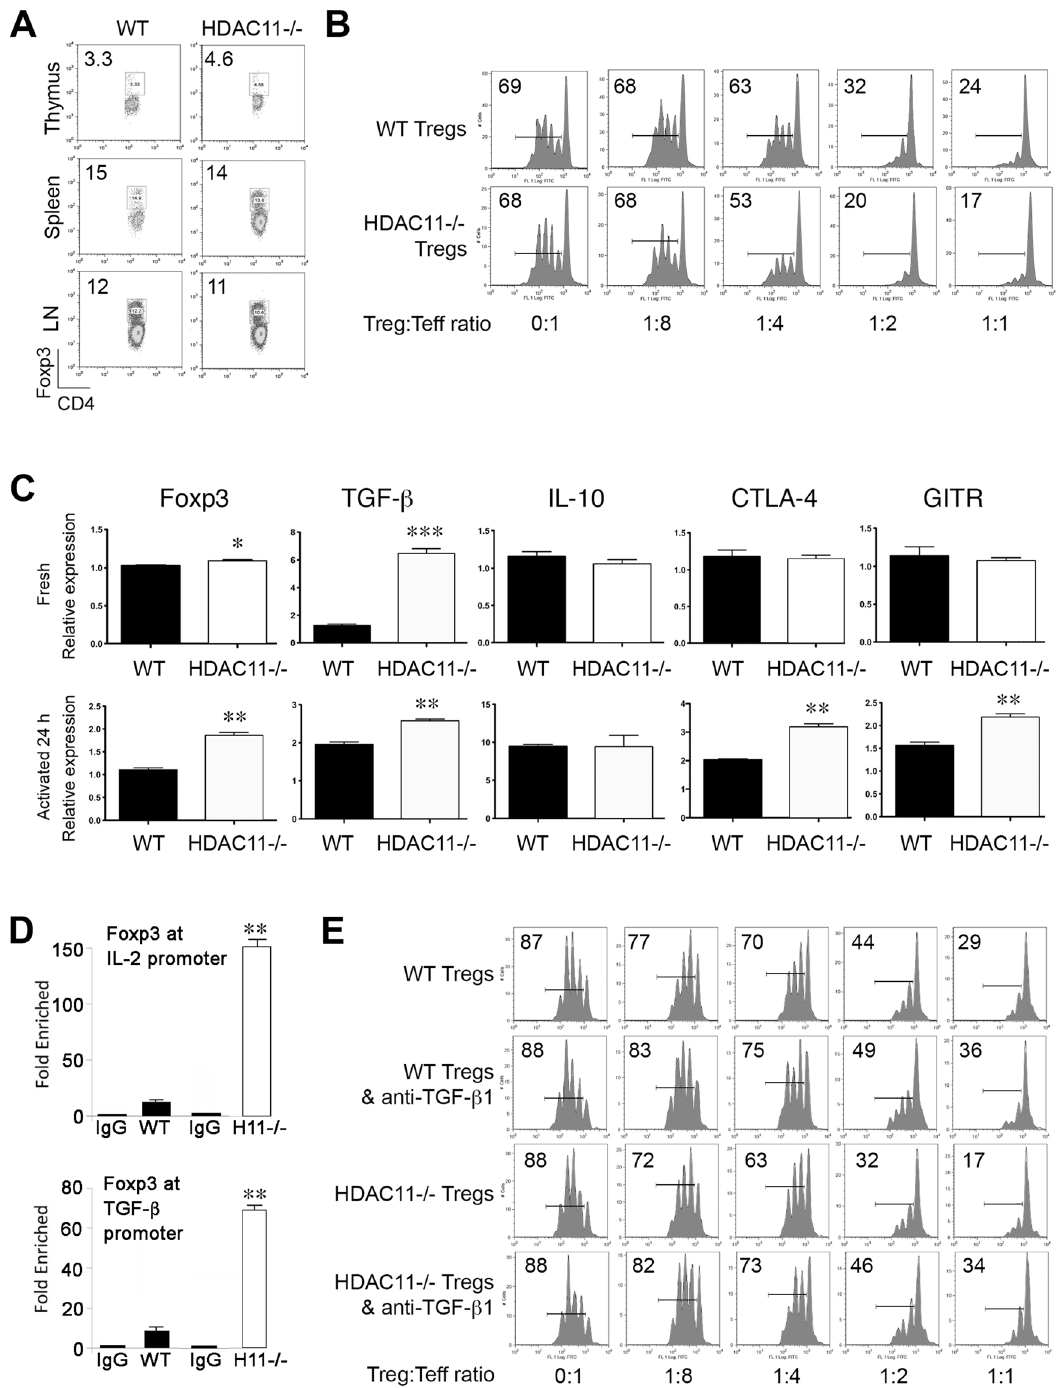
Figure 2. Conditional HDAC11 deletion promotes Foxp3 + Treg suppressive function. ( A ) Deletion of HDAC11 within developing Foxp3 + Tregs did not affect the proportions of thymic, splenic or LN Treg cells; data are from 4 to 6 weeks old male mice, and are representative of results in 4 mice/group. ( B ) In vitro Treg suppression assay of the proliferation of CFSE-labeled WT Teff cells using Tregs from WT vs. conditional HDAC11 − / − mice, with percentage of proliferating cells shown in each panel, and representative of 4 separate experiments. ( C ) Gene expression (qPCR) by WT vs. conditional HDAC11 − / − Tregs at rest or activated with plate-bound CD3/CD28 mAbs for 24 h; normalized gene expression data are shown as mean ± SD, 4 mice/ group; * p < 0.05, ** p < 0.01, *** p < 0.005. ( D ) ChIP assays comparing levels of Foxp3 binding at the IL-2 and TGF- β promoters in WT and HDAC11 − / − Treg cells. ( E ) Enhanced Treg suppressive function in vitro is due, at least in part, to increased TGF- β production, as shown by normalization of the suppressive function of conditional HDAC11 − / − Treg cells when incubated in the presence of a neutralizing anti-TGF- β mAb; the percentage of proliferating cells is shown in each panel and representative of 3 separate